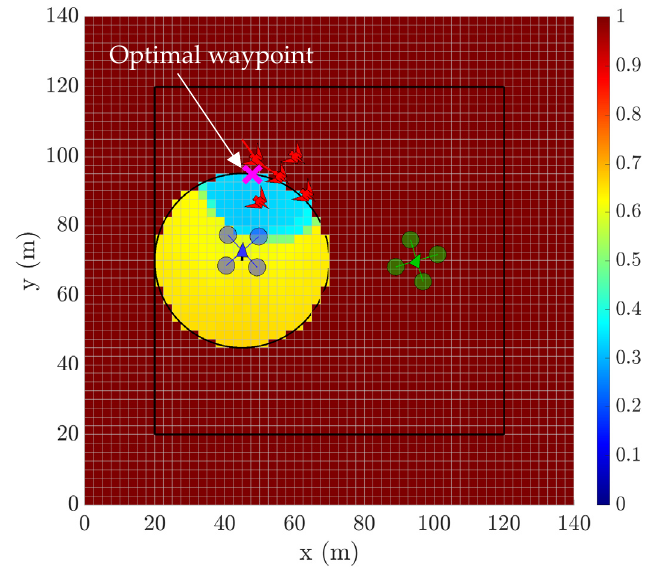
Figure 6. Combined cost function with weightings applied at t = 5 s. Optimal waypoint for left agent is shown and represents the grid cell with minimum cost.